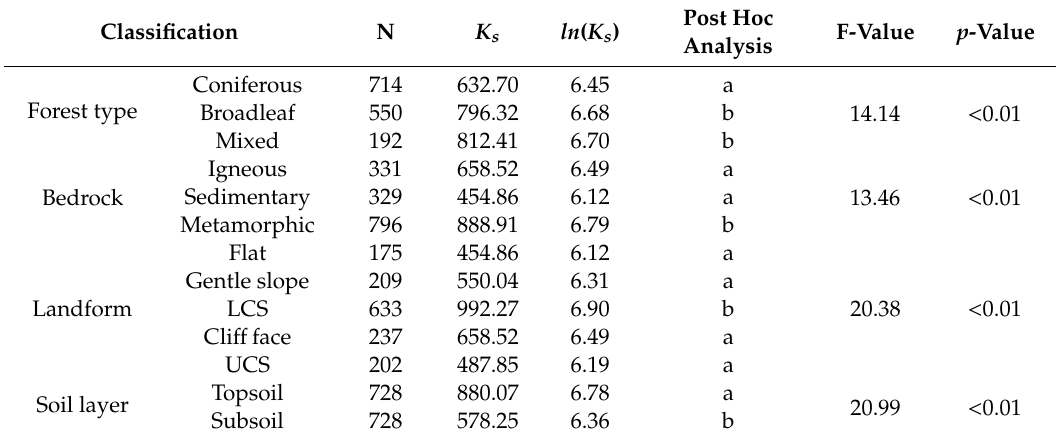
Table 6. The K s di ff erences by forest type, bedrock, landform, and soil layer obtained by ANOVA.